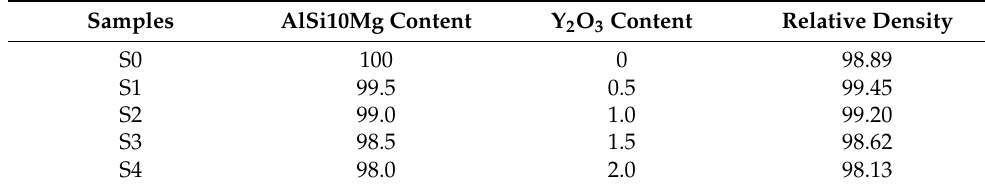
Figure 4. ( a ) Dimensions of the tensile test sample (mm) and ( b ) the image of the polished coupon.